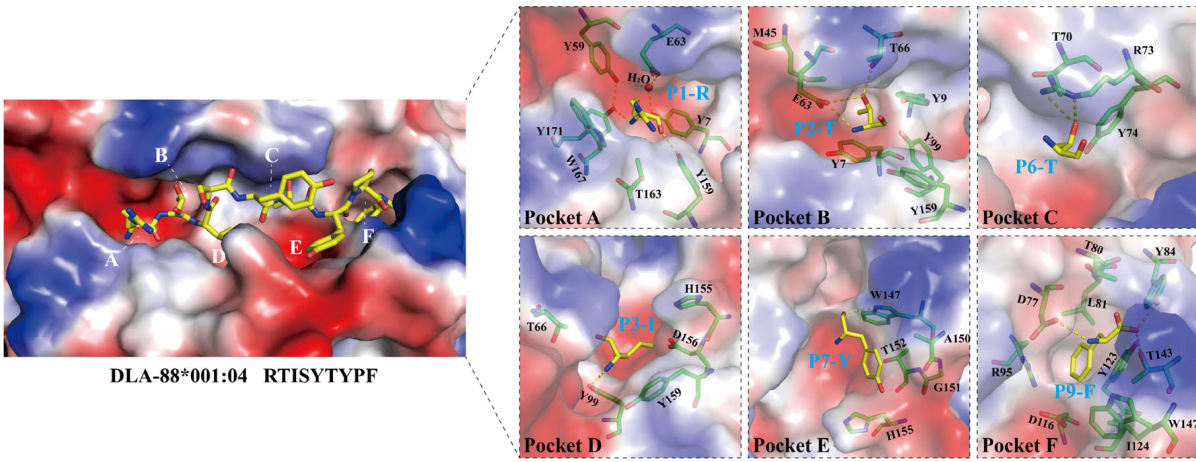
Figure 4. Structural analysis of the PBG of pDLA-88*001:04, its peptide ligand RTI9, and its six binding pockets A-to-F. The H chain is shown in surface format and colored based on vacuum electrostatics: red represents negatively charged, blue represents positively charged, and white represents noncharged. The RTI9 residues are shown in sticks format and element coloring; yellow for carbon, red for oxygen, blue for nitrogen. In the figures on the right, the individual pockets are enlarged and the surface presentation of the H chain is transparent; the H chain residues that interact with the indicated RTI9 residue are highlighted in magenta sticks